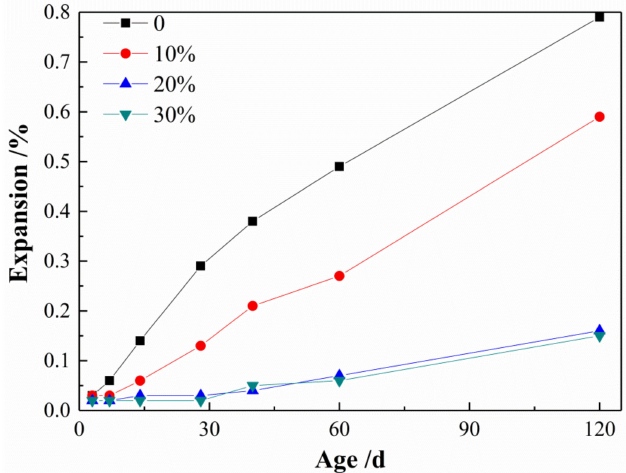
Figure 7. Effect of fly ash content on the mortar rod expansion